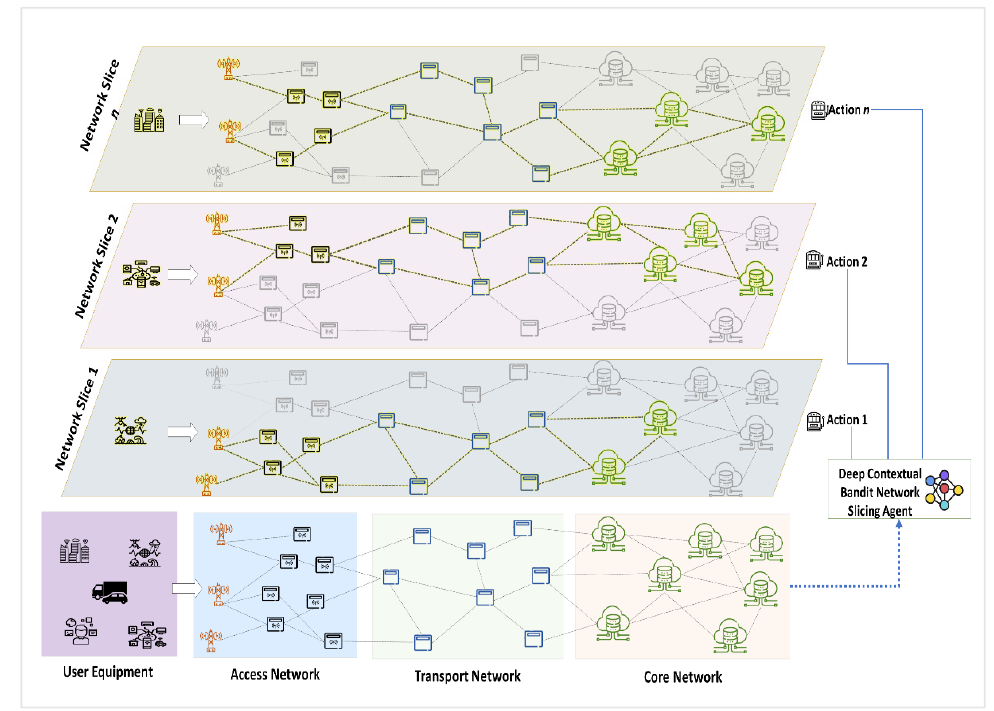
Figure 1. Proposed Deep Contextual Bandit 5G Network Slicing Architecture.